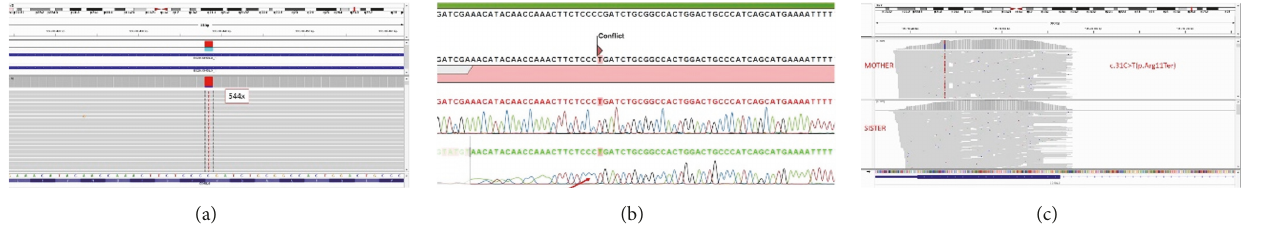
Figure 1: (a) Targeted next generation sequencing analysis in genomic DNA of patient. A nonsense mutation in Exon 1 (c.31C > T) changes an arginine (R) codon (CGA) into a translation termination (X) codon (TGA) at amino acid position 11 (p.Arg11Ter). (b) Sanger sequencing analysis in genomic DNA of patient. (c) The mother was heterozygous carrier and the sister had wild type gene